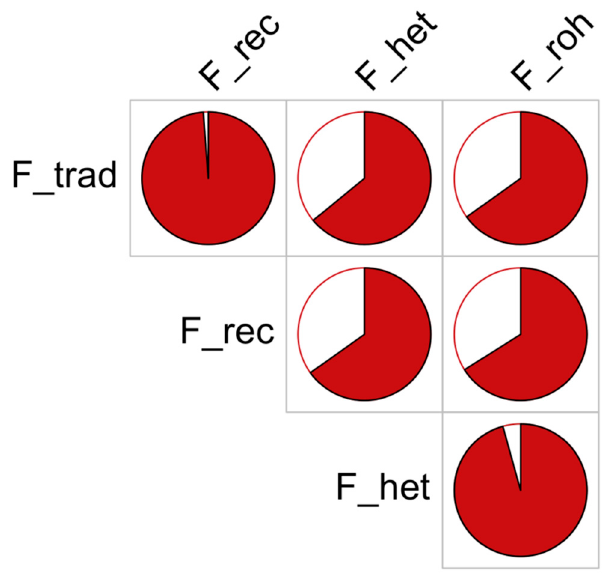
Figure 3. Comparison of inbreeding values obtained using different methods (definitions of methods in the text). The pie charts report the correlations (in red) between each pair of individual inbreeding values obtained with different methods.